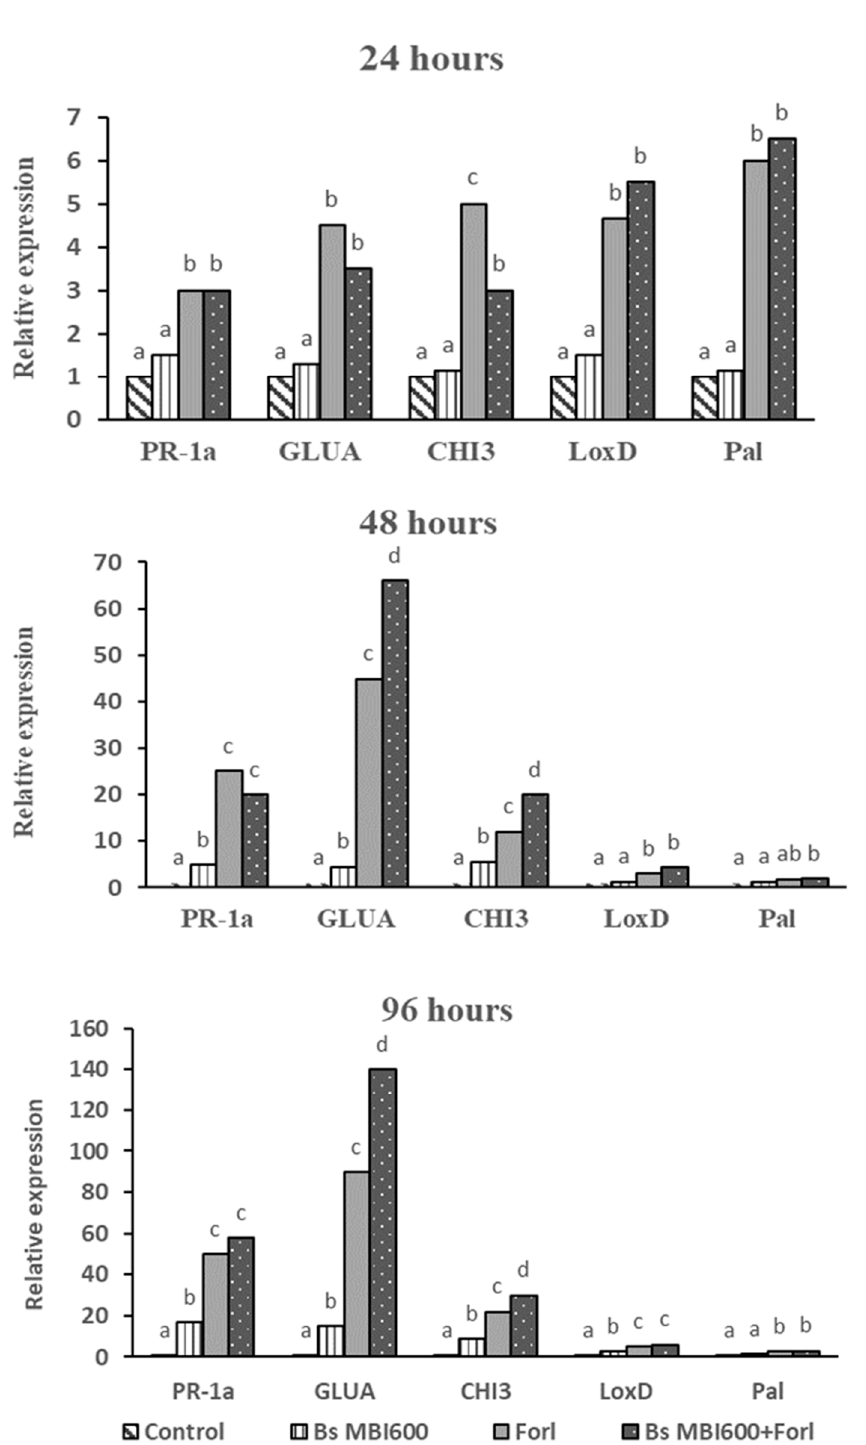
Figure 4. Expression levels of defense-related genes ( PR-1a , GLUA , CHI3 , LoxD and Pal ) in tomato plants (cv. Belladonna) after treatment with Bacillus subtilis MBI 600 (Bs MBI600), inoculation with Fusarium oxysporum f.sp. radicis-lycopersici (Forl), combined application of both microorganisms ( Bs MBI600-Forl) and untreated or non-inoculated plants (control). Expression levels were evaluated by qRT-PCR at 24, 48, and 96 h post-inoculation and the cDNA samples were normalized using the endogenous cox gene. Different letters in the columns indicate significant differences between the different treatments according to Tukey’s test ( p <